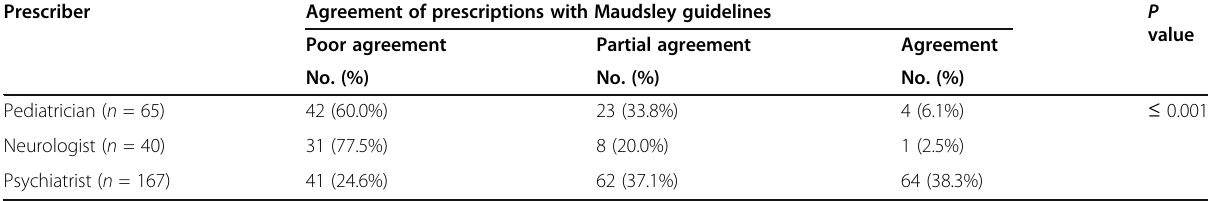
Table 4 Intervention strategies agreement with Maudsley guidelines per